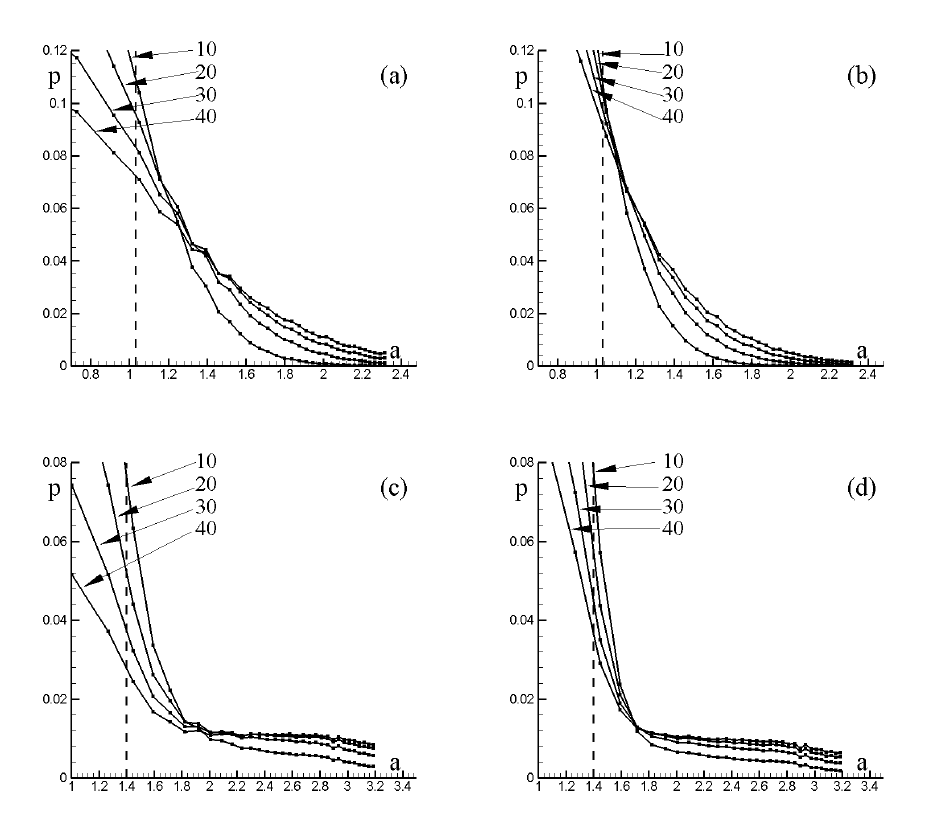
Figure 34. The PDFs versus the ellipsoid’s semi-axis a . Initially, p = 1 inside the ellipsoid and the density disperses in 10, 20, 30, 40 time intervals: The vertical lines mark the ellipsoid’s boundary. ( a , b ) the stationary vortex case with switched-on and switched-off vertical diffusion, respectively; and ( c , d ) the non-stationary vortex case with switched-on and switched-off vertical diffusion,